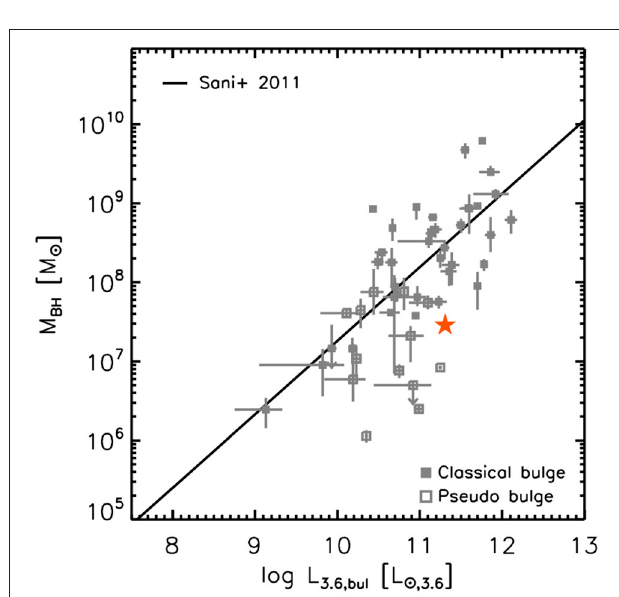
FIGURE 3 | The M BH -L 3.6, bul plane for local sample of galaxies with a dynamic or maser measurements of M BH , the position of NGC 1275 is marked with an orange star. The scaling relation of Sani et al. (2011) is also shown for seek of comparison.